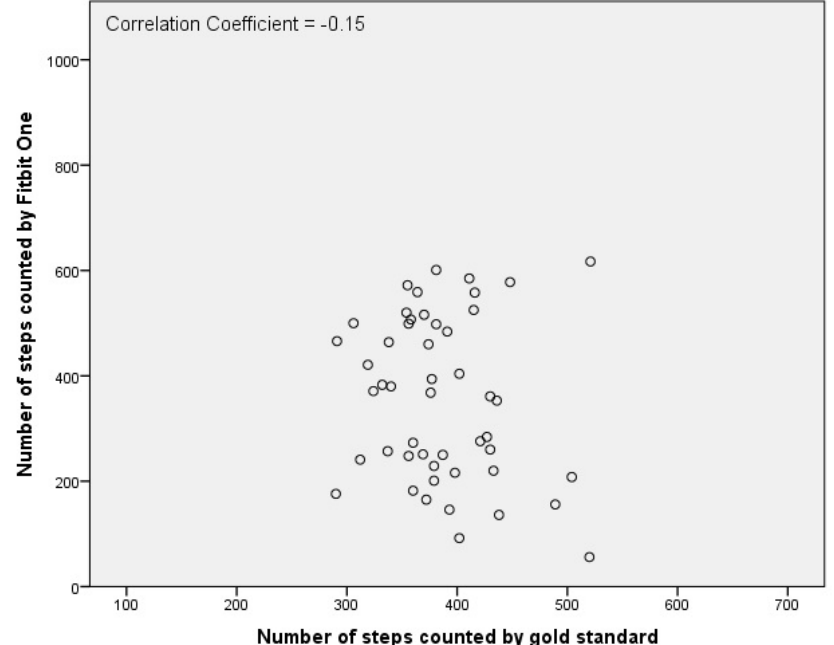
Figure 1. Scatterplot of the number of steps counted by Fitbit One and the gold